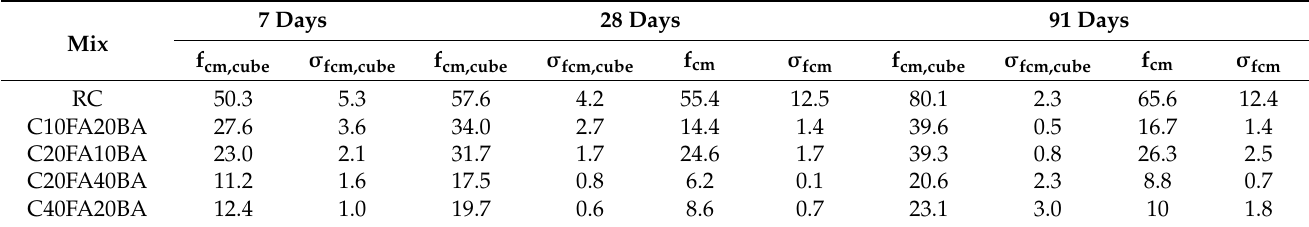
Table 4. Compressive strength (MPa) cylindrical and cubic specimens.